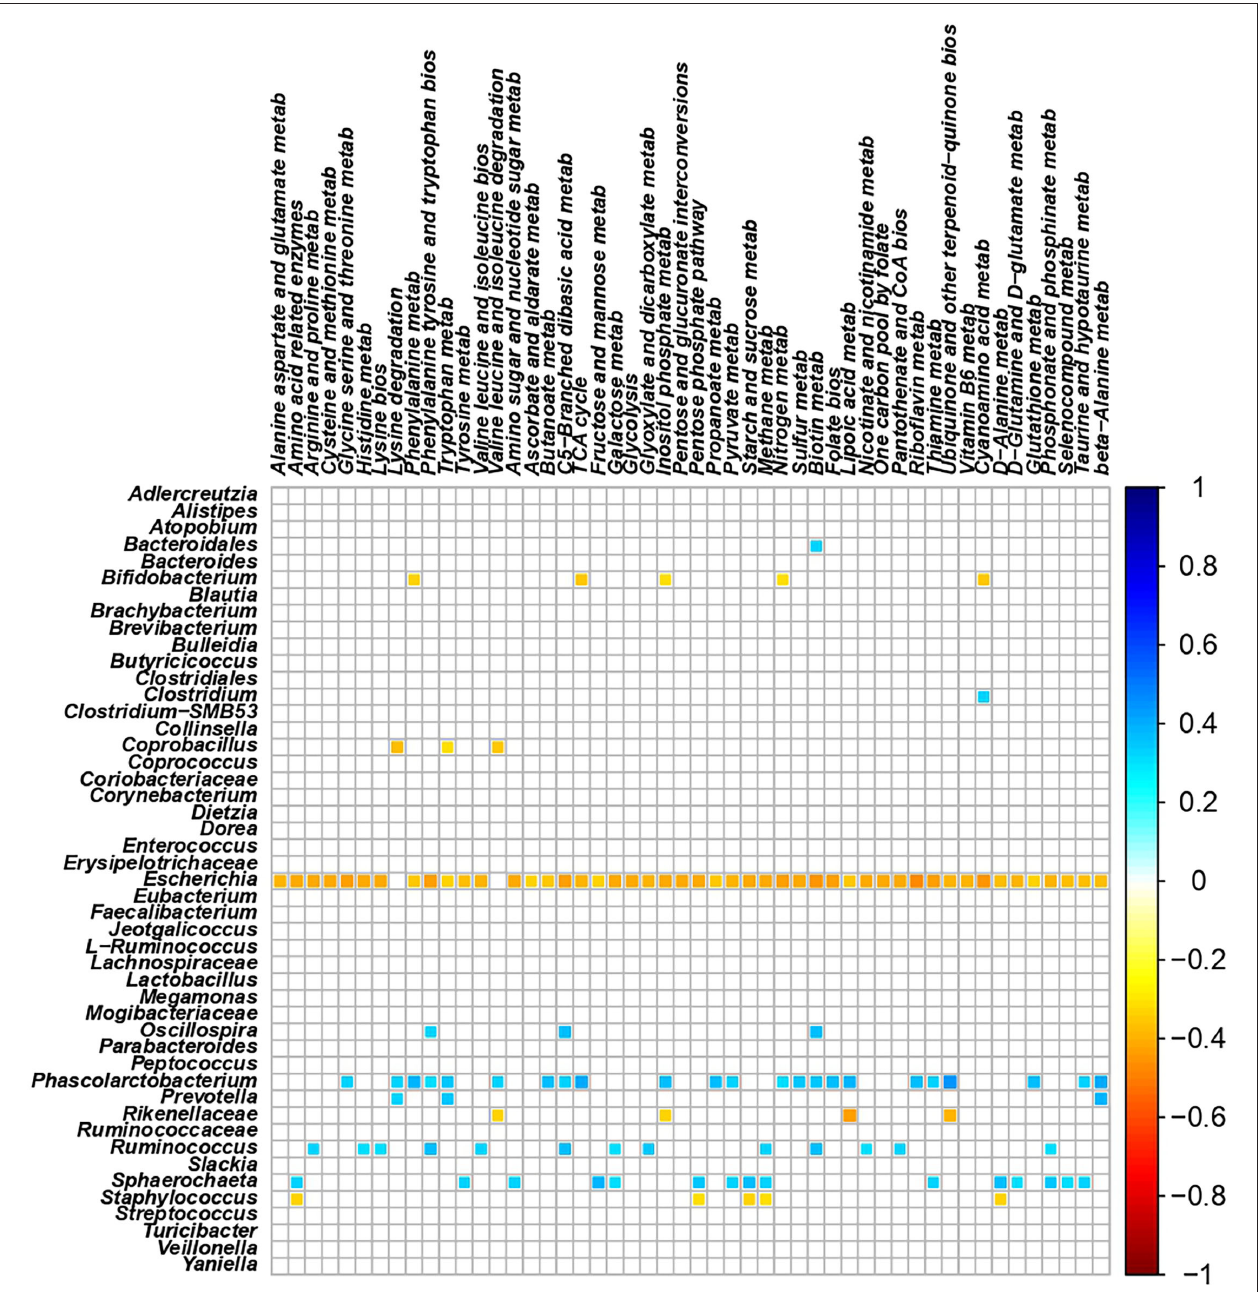
FIGURE 4 | Correlation plot showing the Spearman’s correlation between OTUs and predicted metabolic pathways. The intensity of the colors represents the degree of correlation between the OTUs and predicted metabolic pathways as measured by the Spearman’s correlation. Only significant correlation ( p < 0.05) are